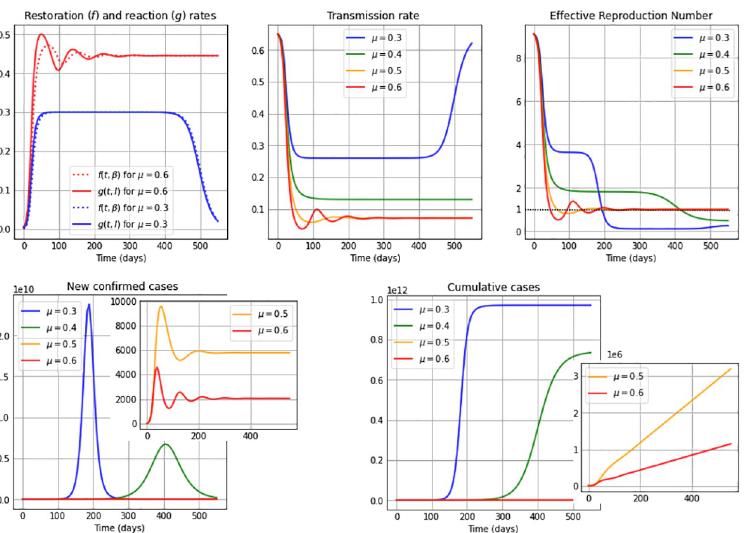
Fig 2. Simulations for a medium restoration coefficient ν = 0.5. The first subplot illustrates the restoration rate f ( t , β ) (dotted) and the reaction rate g ( t , I ) (solid). The remaining subplots show: The transmission rate β ( t ), the effective reproduction number R ð t Þ , the new confirmed cases eE ( t ), and the cumulative cases E ( t ) + I ( t ) + R ( t ). The reaction e coefficient in each subplot are chosen to be μ : 0.3 (blue); 0.4 (green); 0.5 (orange) and 0.6 (red), and the remaining parameter values and initial conditions are as in Table 2.